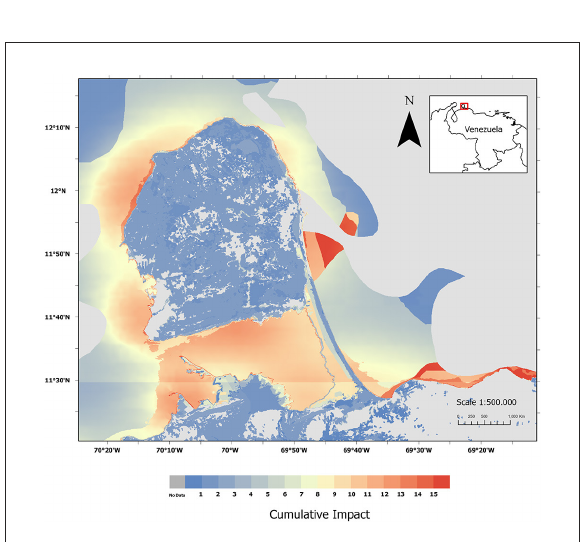
FIGURE8 Map of cumulative impacts of multiple natural and anthropic disturbances on the central coast of Falcón state,